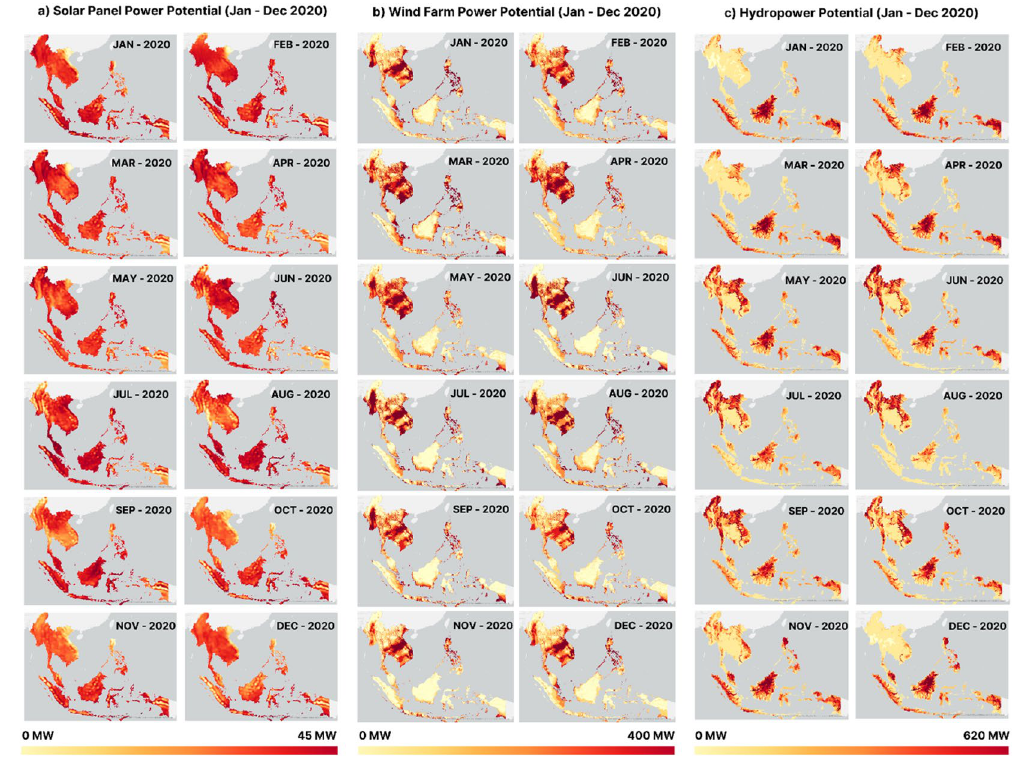
Figure 3. Map visualization of monthly power potential (January–December 2020) for ( a ) solar panels, ( b ) wind farms, and ( c )